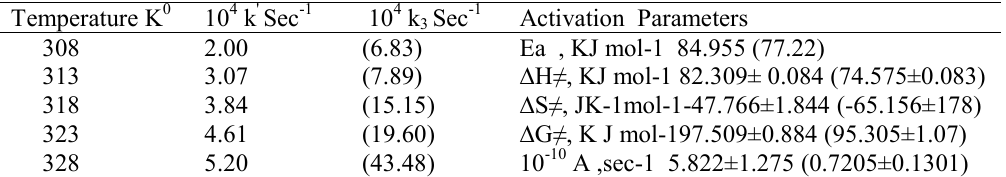
Table 3. Effect of temperature on the reaction rate and activation